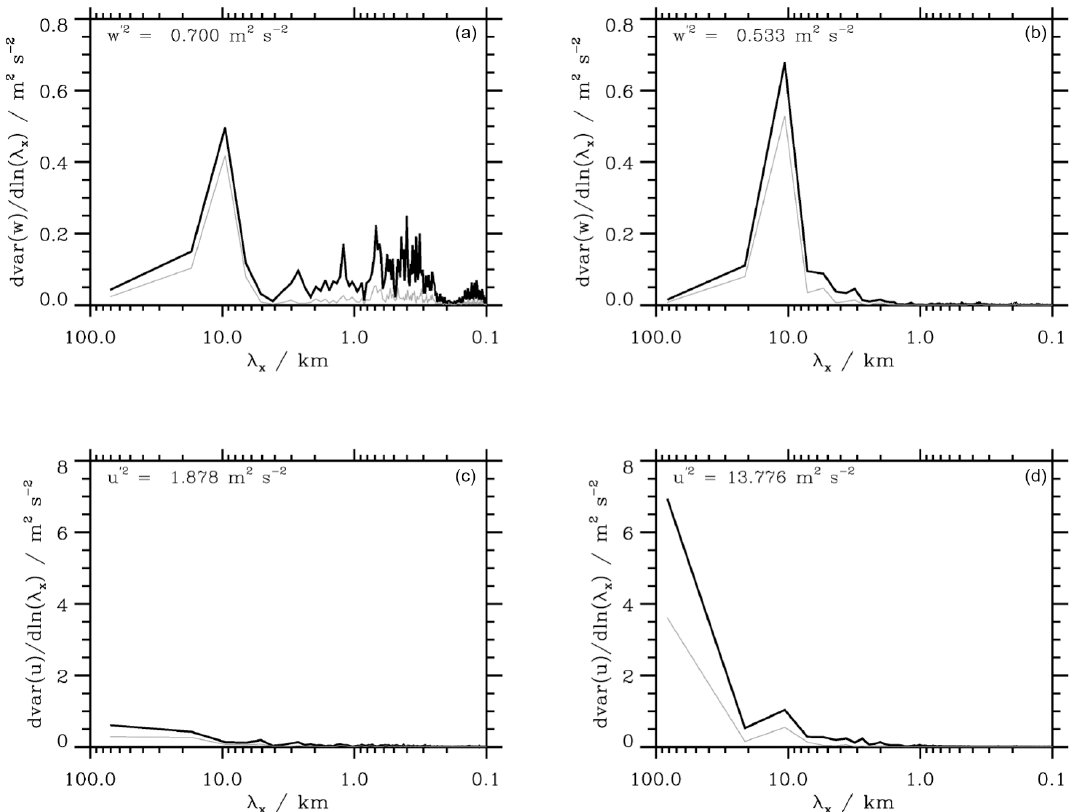
Figure 4. Binned energy spectra for the vertical wind component w (a, b) and the horizontal wind V H (c, d) from the two southern flight legs of FF09, which crossed the mountains based on the 10Hz data (corresponding to flight segments from 17:30–17:50UTC and 18:47– 19:07UTC in Fig. 2). The left column shows the lower tropospheric flight track. Thick black lines are results without tapering window, thin black lines are spectra tapered with a Hanning window. Table 1. Wave momentum and wave energy fluxes for the two southern legs separated in upstream, downstream and across mountain side according to Fig. 6. Tropospheric leg Stratospheric leg Upstream